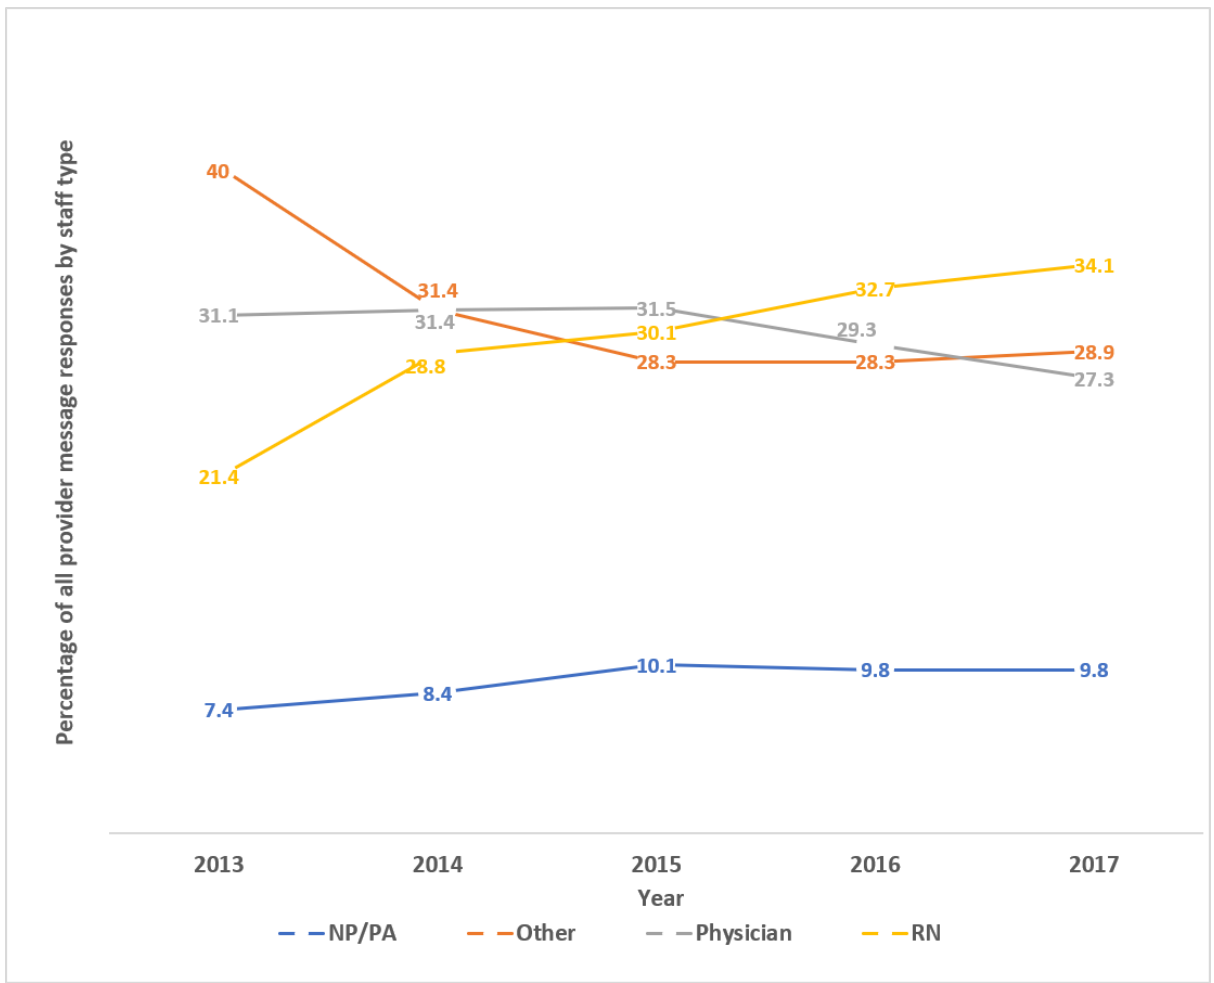
Figure 6. Percentage staff distribution responding to patient messages by